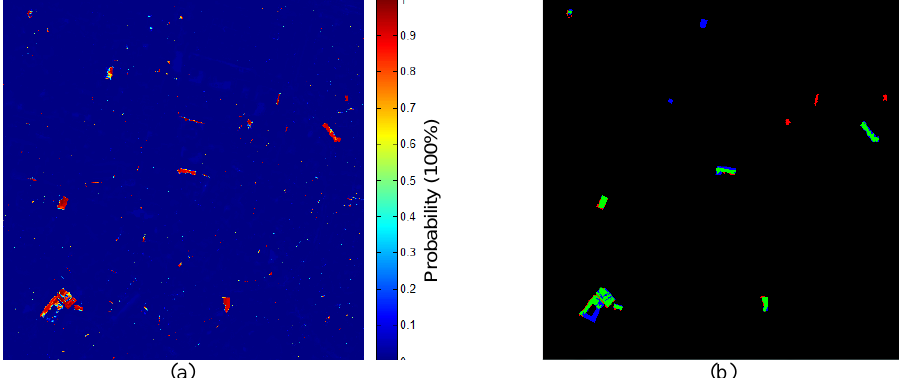
Figure 6. Change map (a) and change mask (b) generated in the Munich test area with Method II.